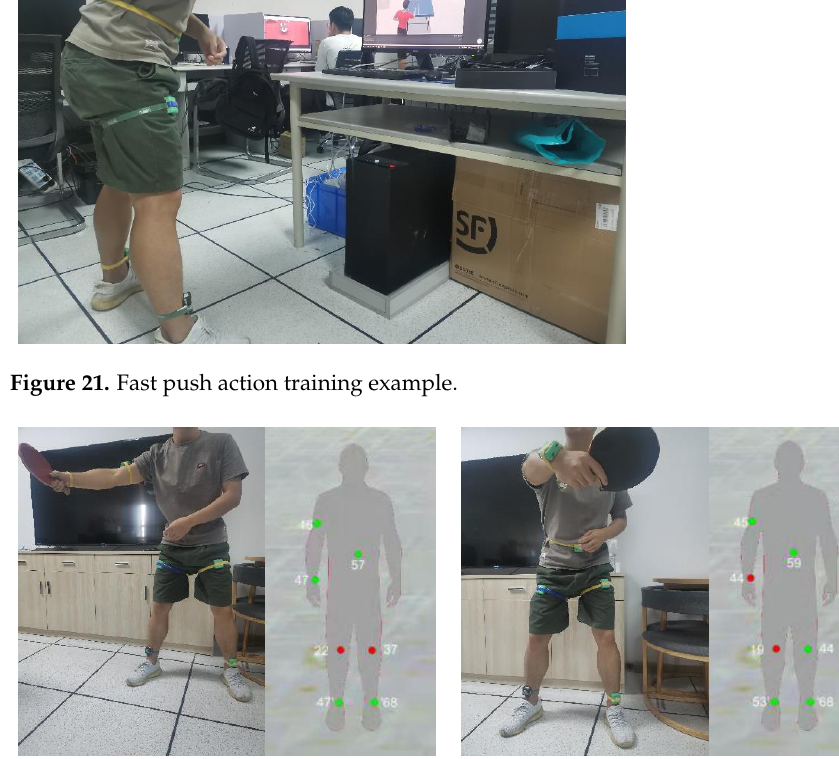
Figure 22. Fast push action of correct and wrong actions and evaluation results. ( a ) is a relatively standardized action. ( b ) subject’s hand action is wrong .